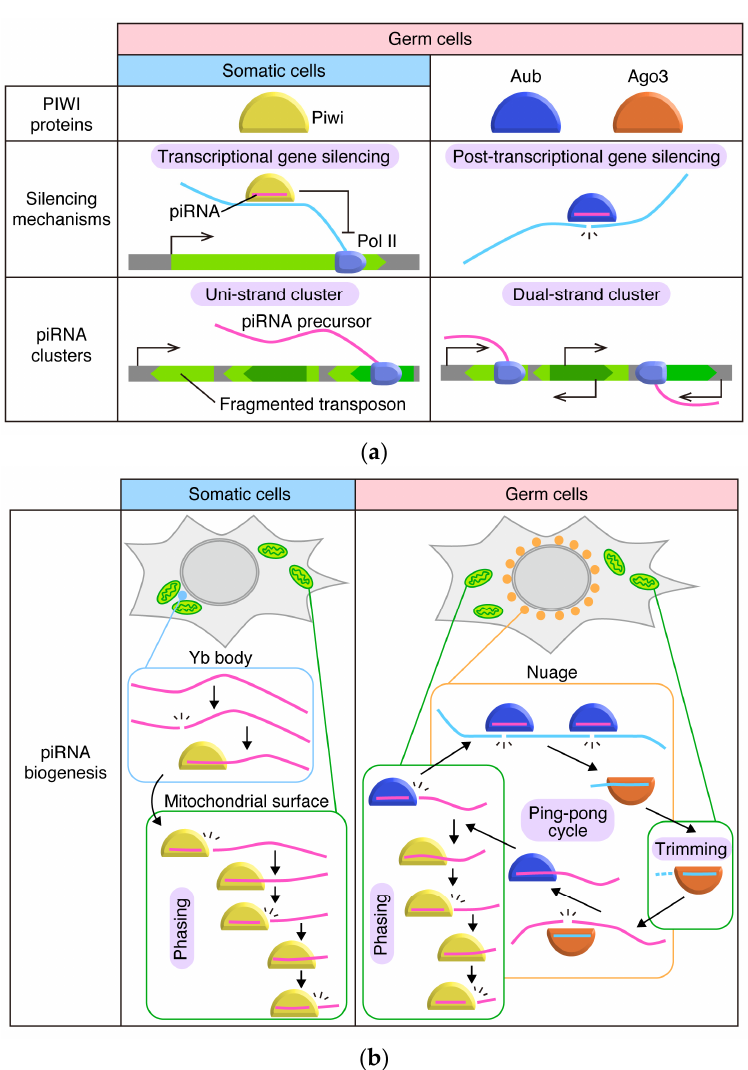
Figure 1. Comparison of Drosophila ovarian piRNA pathways in somatic cells and germ cells. ( a ) Comparison of PIWI proteins, silencing mechanisms, and piRNA clusters. Sole PIWI protein expressed in somatic cells, Piwi, is imported to nuclei once loaded with piRNA and represses transposon co-transcriptionally. In somatic cells, piRNA precursors are transcribed from uni-strand clusters, which are transcribed uni-directionally and produce transcripts harboring fragments of transposons in reverse orientation. In germ cells, Aub and Ago3 are expressed in addition to Piwi. Aub and Ago3 stay in the cytoplasm and cleave target transcripts using Slicer activities. piRNAs in germ cells are derived from both uni-strand and dual-strand clusters. Dual-strand clusters are transcribed from both strands of DNA, and transposon fragments are inserted in random orientations. ( b ) Comparison of piRNA biogenesis pathways. In somatic cells, dominant piRNA precursors, flamenco / COM ( flam ) transcripts, are selected and initially cleaved in Yb bodies, soma-specific perinuclear granules surrounded by mitochondria. Continuous cleavages of intermediate RNA on the outer membrane of mitochondria produce mature ‘phased’ piRNAs. In germ cells, reciprocal cleavage of target transcripts by Aub and Ago3 produce Ago3-bound and Aub-bound piRNAs, respectively. This cycle is called the ping-pong cycle. Through the ping-pong cycle, transposon transcripts (light blue) are cleaved and piRNAs are amplified. Cleavage of targets and loading of cleaved fragments onto PIWI proteins during the cycle occurs in germ-specific perinuclear granules called nuage. Maturation of Ago3-loaded piRNAs through trimming presumably occurs on the outer membrane of mitochondria. Loading of antisense RNA (magenta) on Aub triggers phased piRNA biogenesis on the mitochondrial outer membrane.